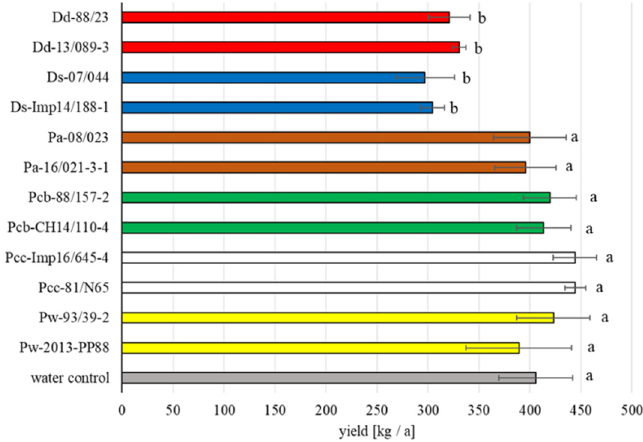
Figure 4. Yield in kg per are of the trials using potatoes infected with 12 bacterial strains in the field assay for 2020. Mean value of four repetitions for each strain, with standard deviation bars. Different letters indicate statistical differences according to pairwise multiple comparison (ANOVA based) of the mean incidence value between the strains. This is a repetition of the assay 2018.